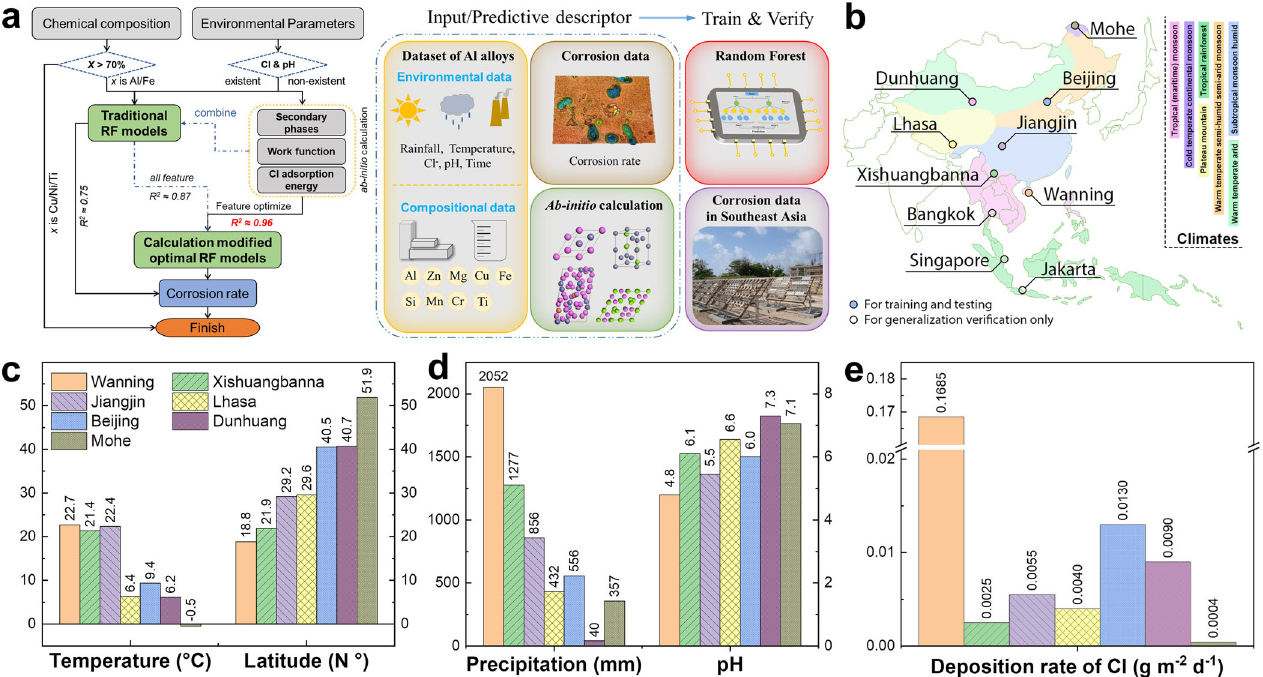
Fig. 1 Calculations modi fi ed RF model fl ow and the fi eld exposure sites. a ML fl ow diagram and dataset features. b Placement map. Corrosion data obtained in Singapore, Jakarta, and Bangkok are only used for generalization veri fi cation. c – e The climate characteristics of regions. The fi eld exposure time of Al alloys is range from 0.5 to 4 years.